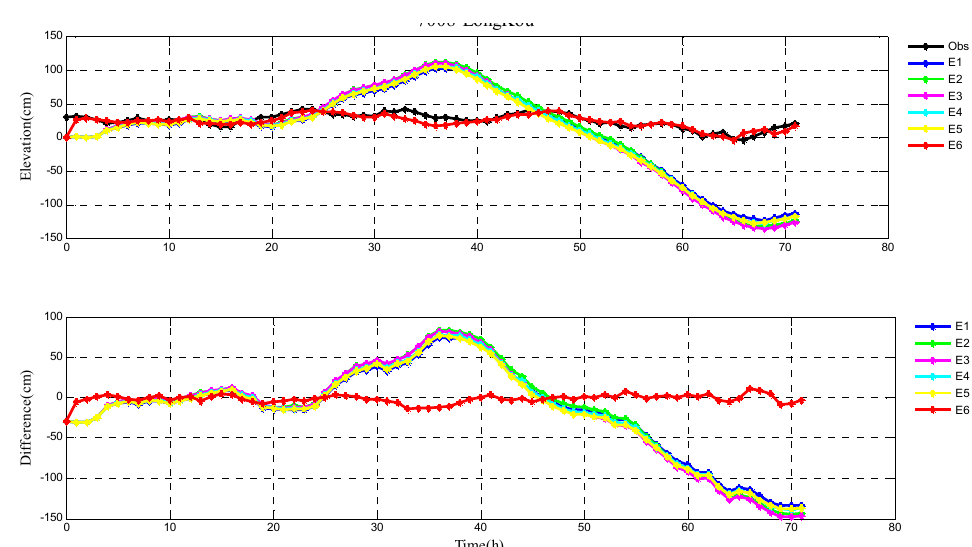
Figure 5. Storm surge elevations in six experiments (E1–E6), observations (black line) ( top ), and the differences between them ( bottom ) during Typhoon 7008 at YingKou station.